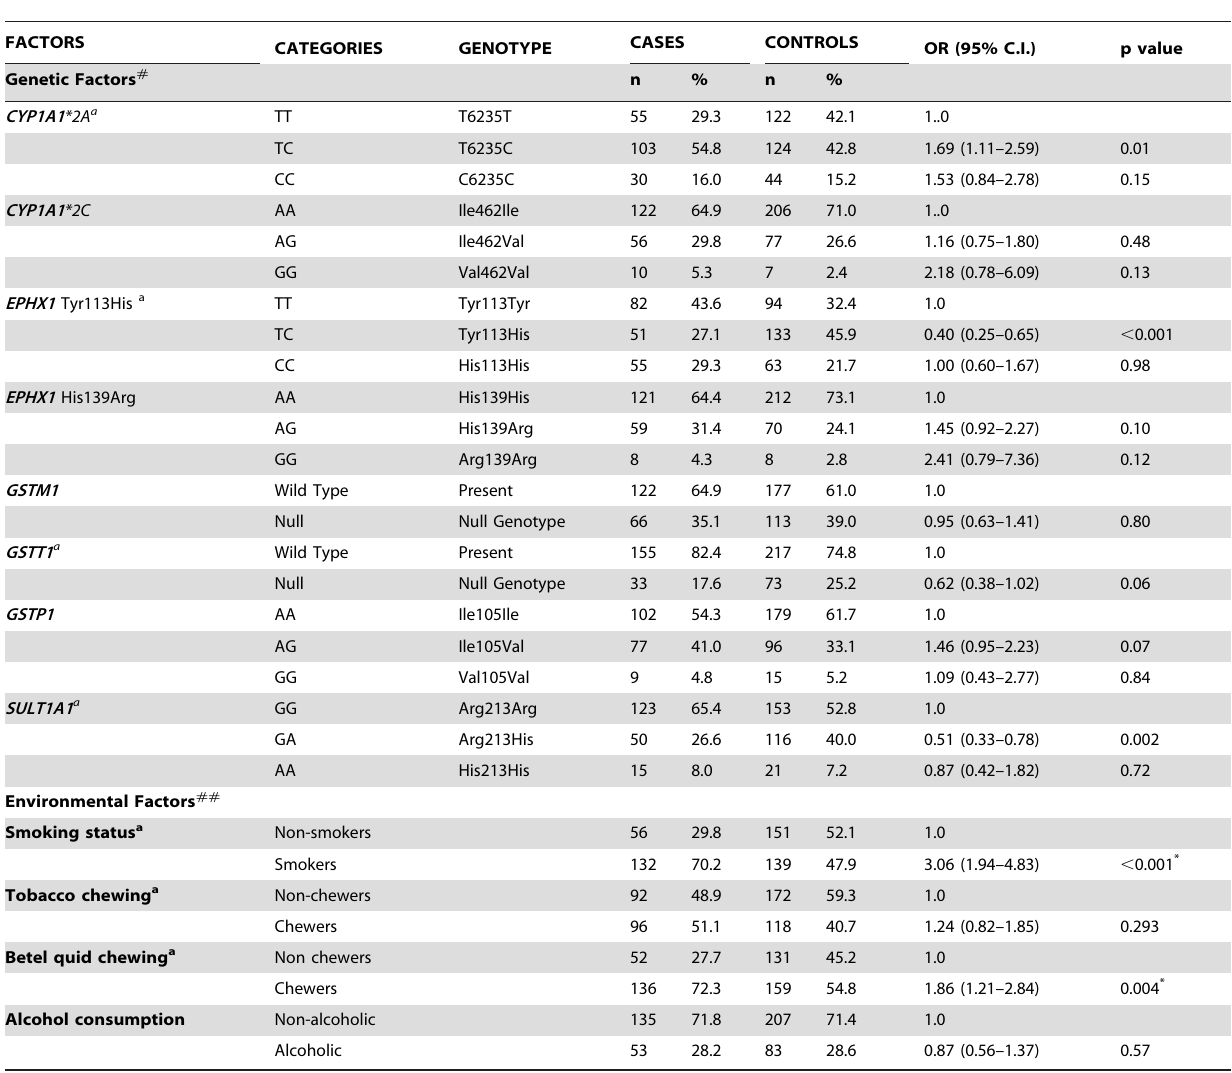
Table 1. Association of genotypes of xenobiotic metabolizing genes and environmental risk factors with lung cancer